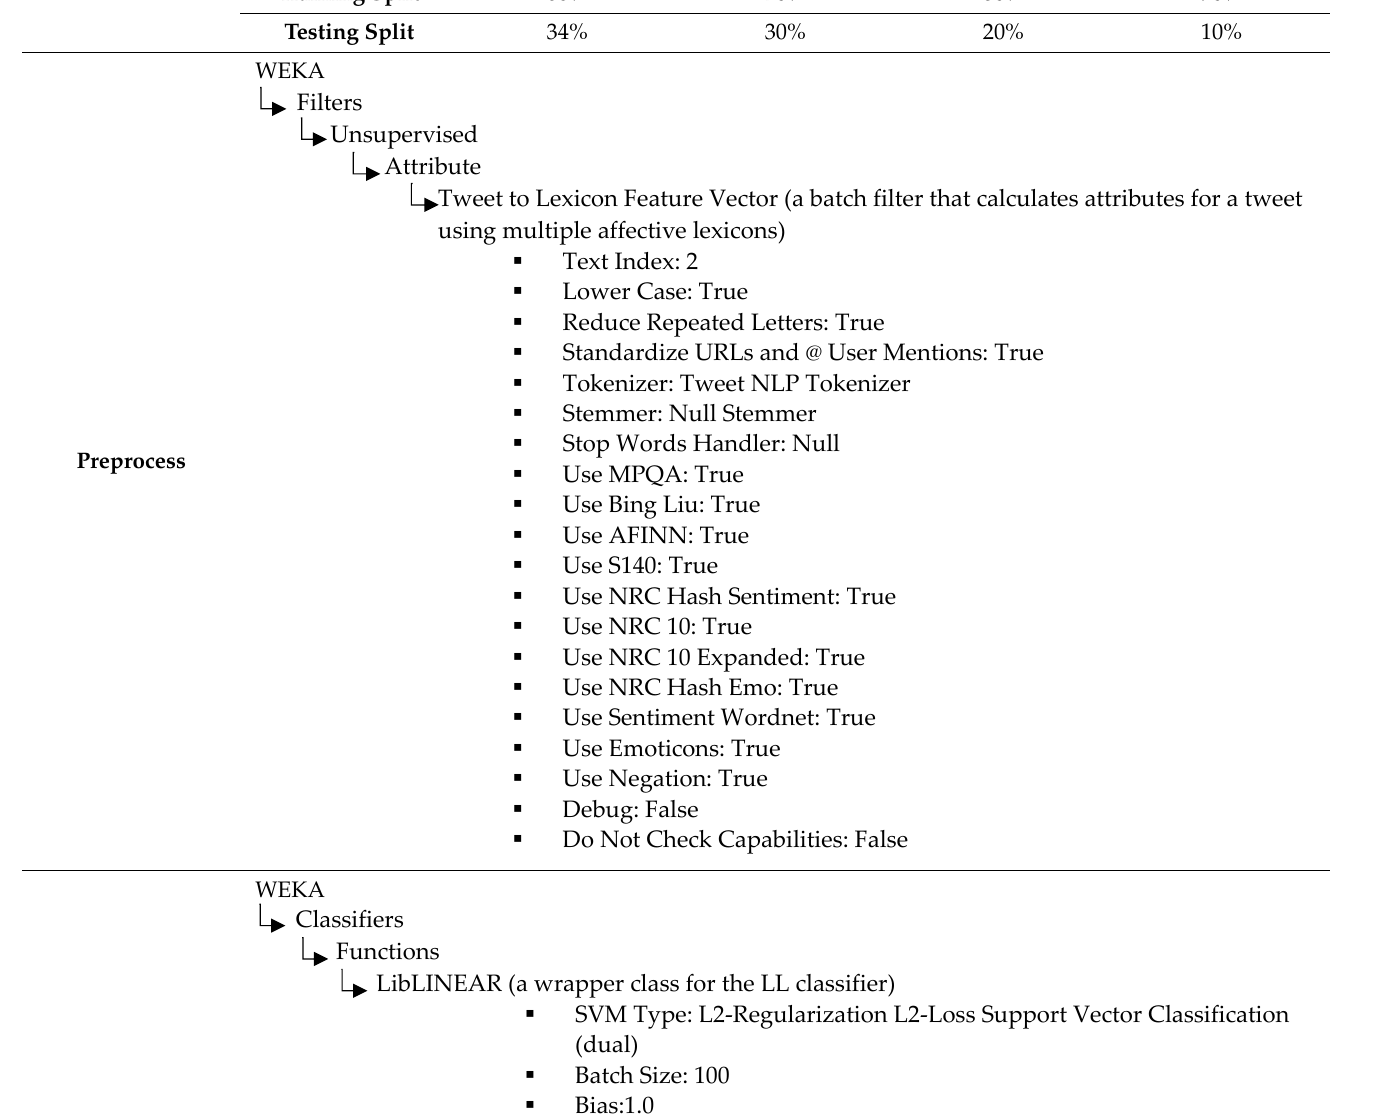
Table 2. Run information (single feature selection technique).